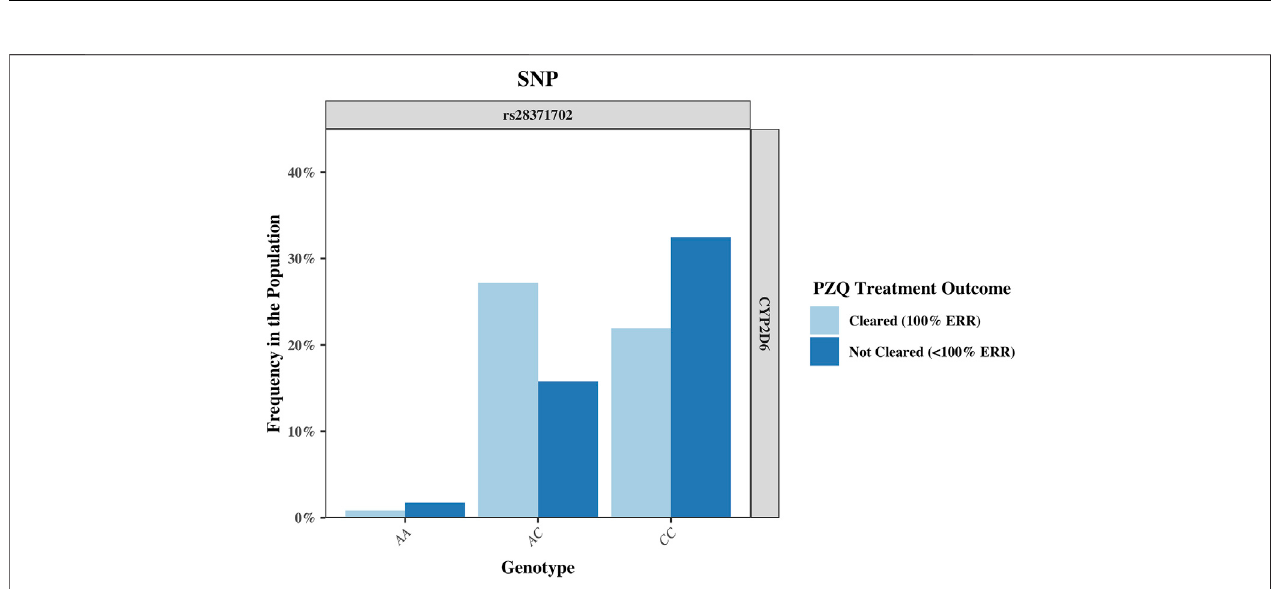
FIGURE 3 | The frequency of the single nucleotide polymorphism (SNP) rs28371702 in the CYP2D6 gene, separated by genotype and sub-divided by PZQ treatmentoutcome.Thegenotype forthers28371702isasfollows: AA(reference allele),AC(heterozygous foralternateallele), andCC(homozygousforalternateallele). PZQ: Praziquantel, ERR: Egg reduction